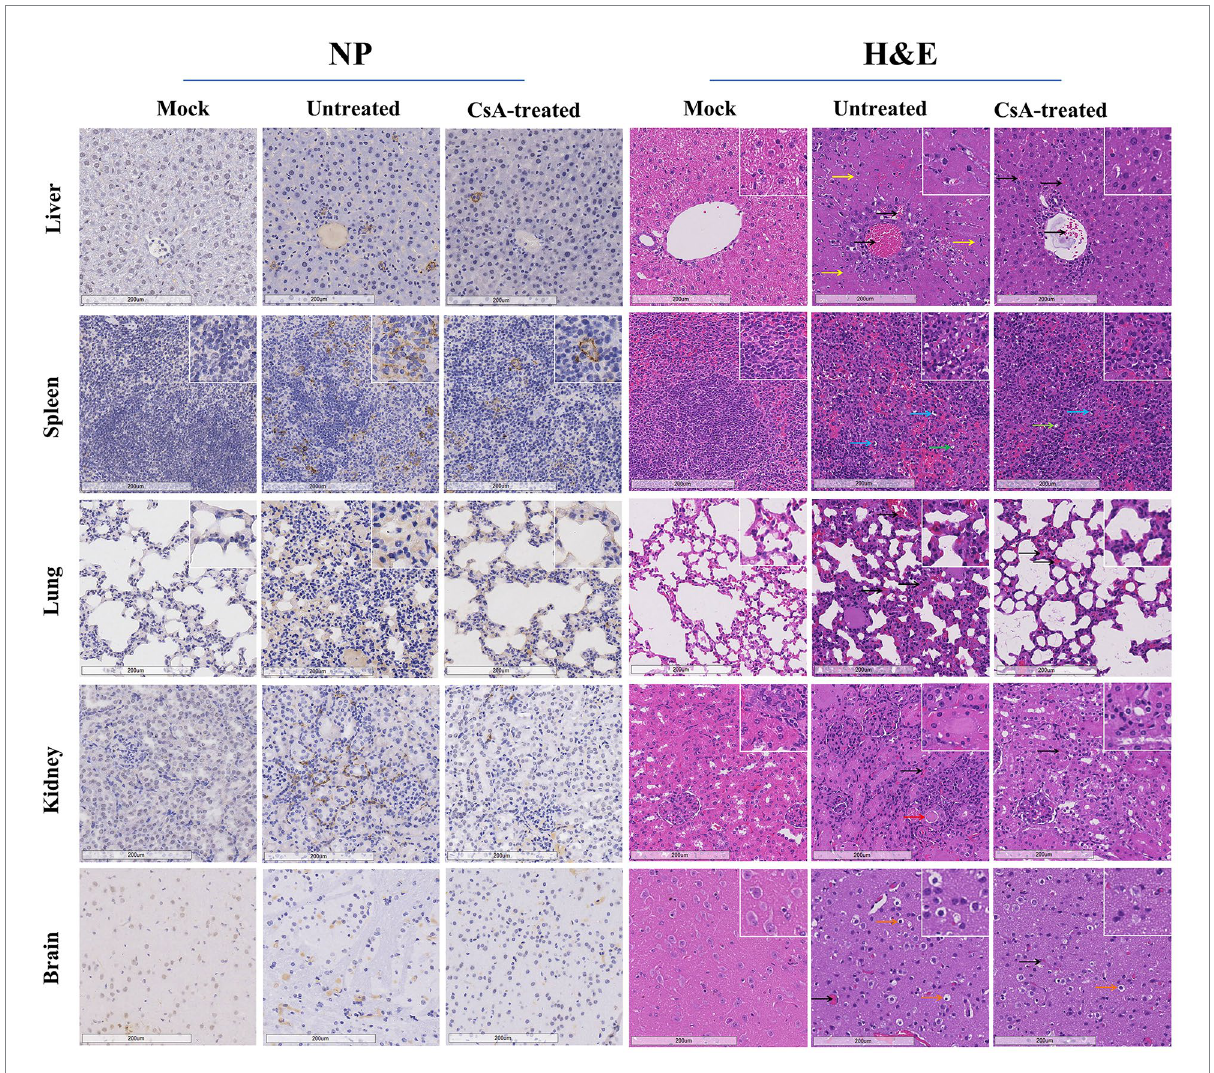
FIGURE 6 Pathology of IFNAR − / − mice infected with SFTSV. Immunohistochemical (left) and histopathological (right) examinations of the tissues collected from the mock, untreated and CsA-treated mice. Tissues were collected from mice on day 7 (untreated mice) or day 9 (mock and CsA-treated mice). Bars, 200 μ m. The black arrows indicate hyperemia, yellow arrows indicate necrosis, red arrows indicate protein cast, blue arrows indicate lymphocyte pyknosis, green arrows indicate lymphoid nucleus deletion, while orange arrows indicate neuronal